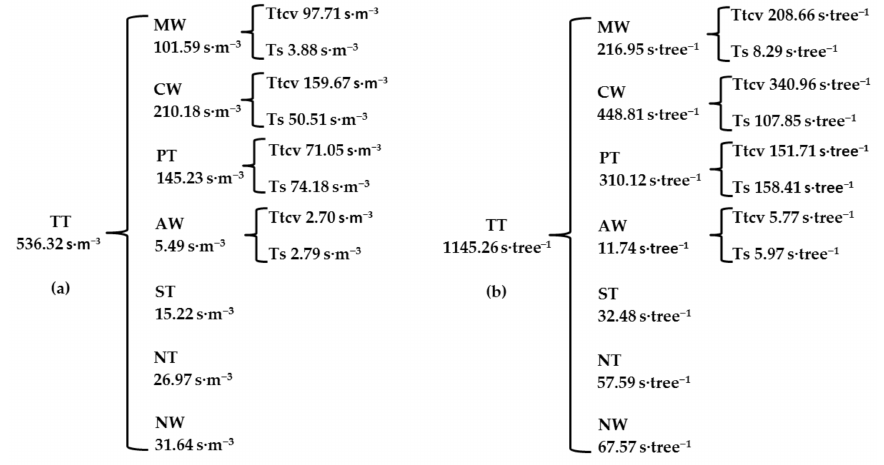
Figure 3. Total work time structure: ( a ) times are expressed in s · m − 3 ; ( b ) times are expressed in s · tree − 1 .